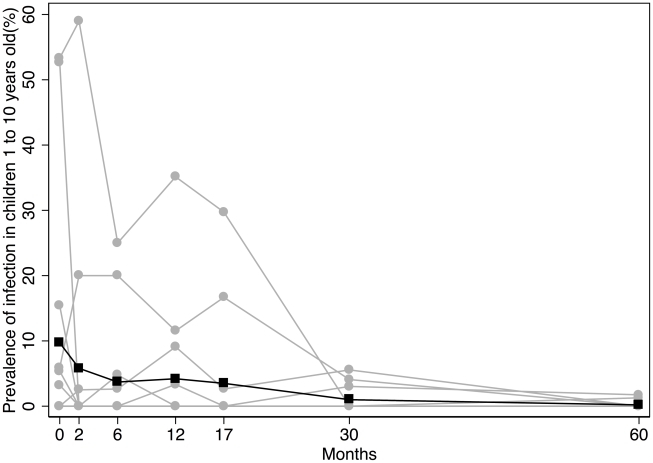
The prevalence of Chlamydia trachomatis infection* in children aged 1 to 9 years for the 14 villages†.Individual villages are represented by the grey lines. Several villages overlie each other with a prevalence of 0%. The overall village level average is represented by the black line. *Chlamydia trachomatis infection determined by Amplicor CT PCR assay. †Village No. 12 withdrew after 17-months.